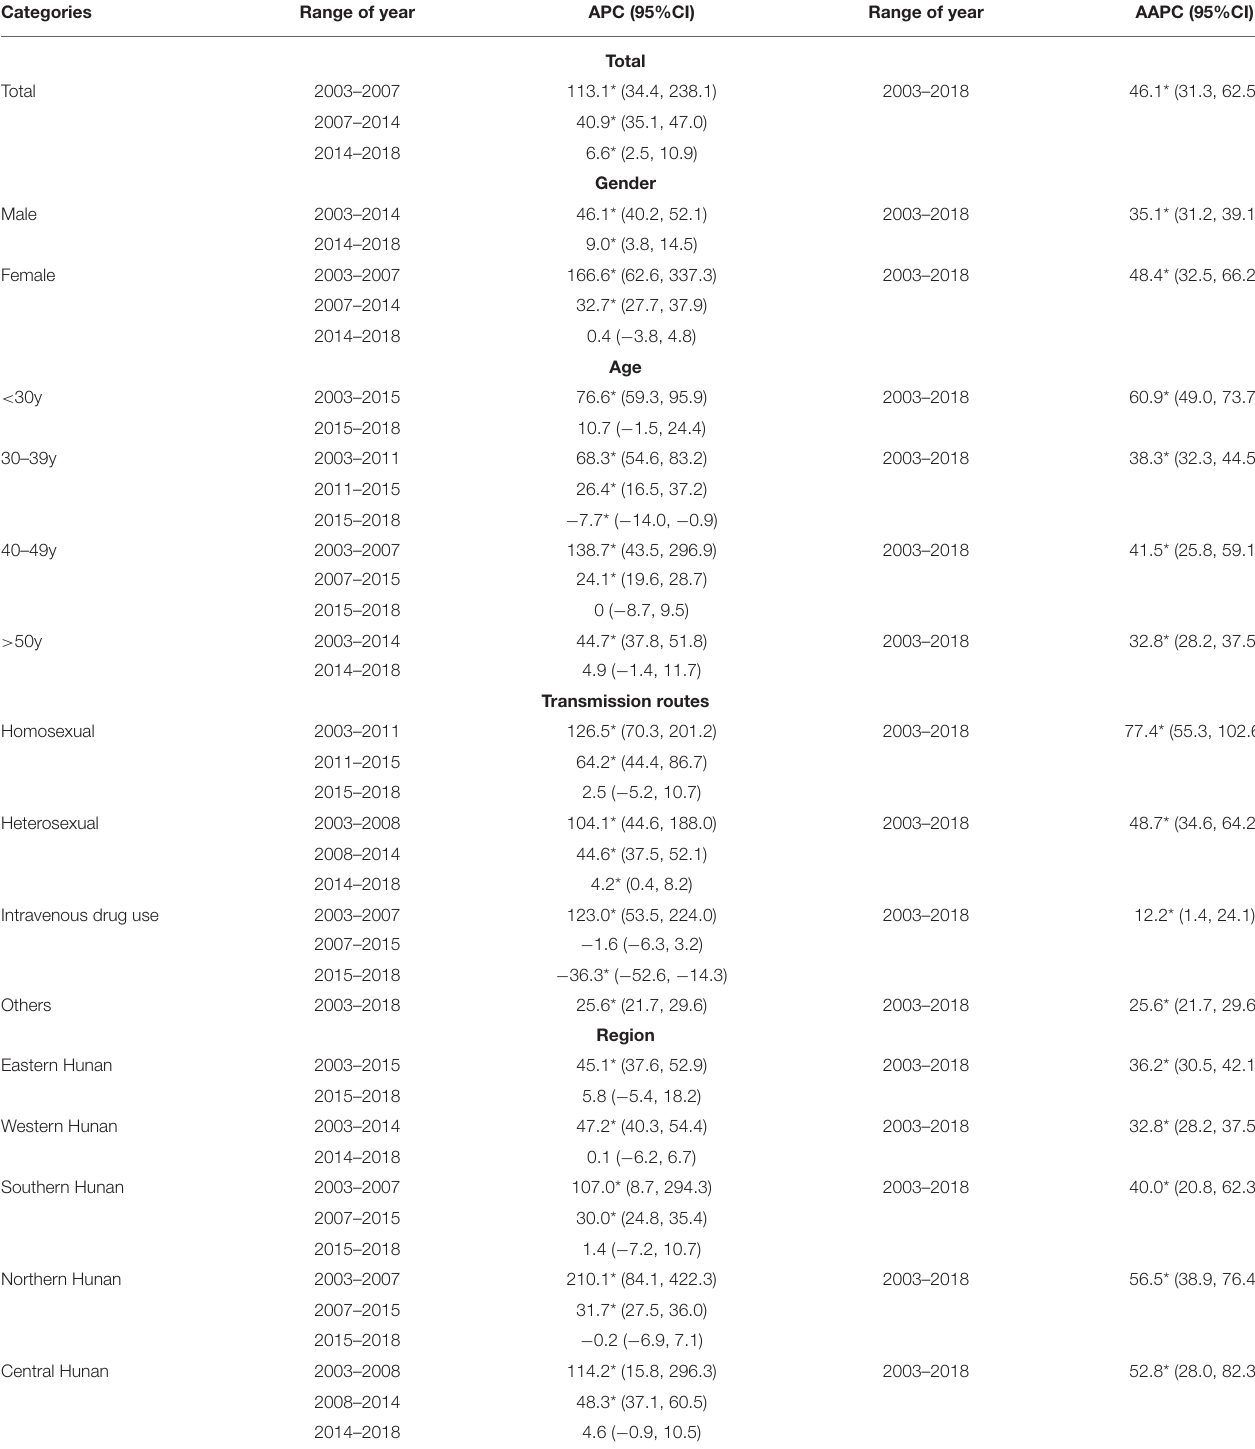
TABLE 2 | Temporal trend analysis of HIV cases stratified by gender, age, transmission routes, and geographical